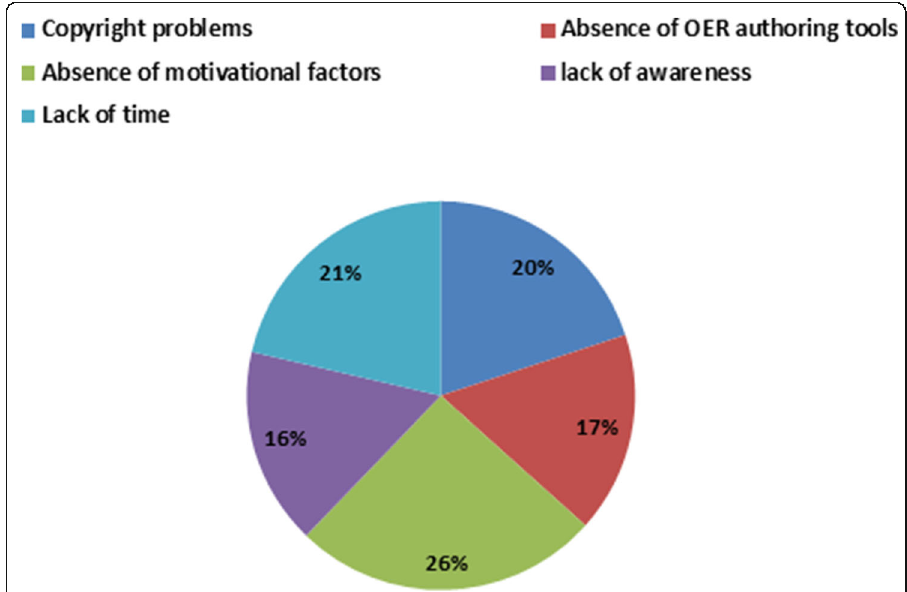
Fig. 5 OER challenges in the Arab